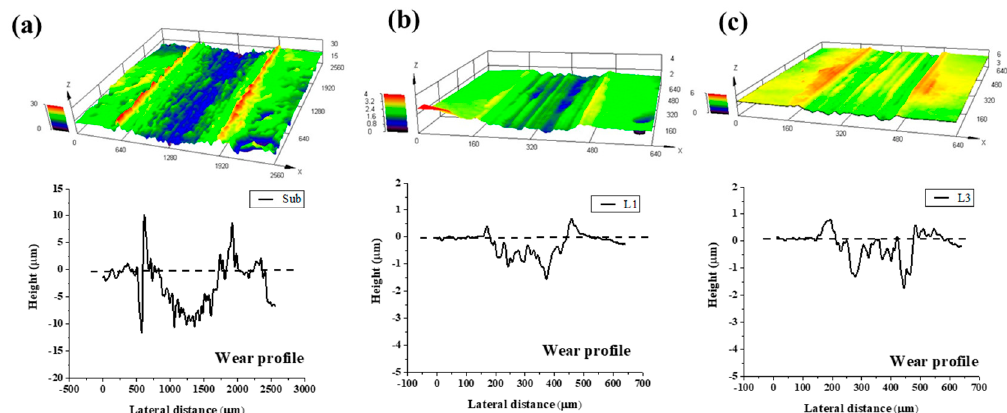
Figure 10. Surface wear of the substrate and the coating under the dry sliding friction and wear test conditions with a sliding friction load of 10N and a wear time of 1800 s: ( a ) Sub, ( b ) L1, ( c ) L3.